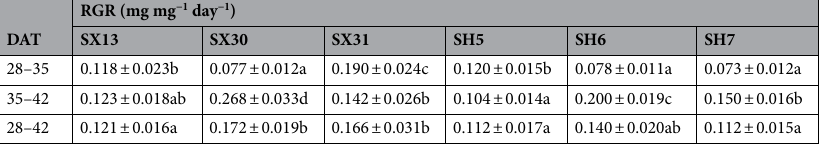
Table 2. The RGR of D. sophia subpopulations from Henan and Xinjiang under monoculture condition. Different lowercase indicated significant difference with p <0.05.